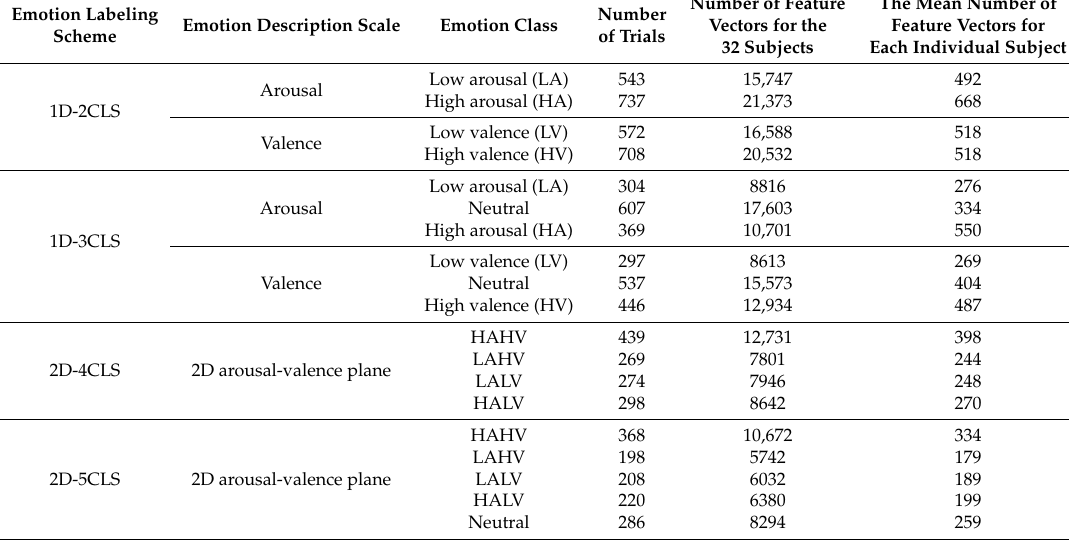
Table 1. The number of trials and feature vectors per emotion class for each labeling scheme. The table includes the total number of trials for the 32 subjects, the total number of feature vectors (number of trials × number of windows per trial) for the 32 subjects and the mean number of feature vectors (number of trials × number of windows per trial/32 subjects) for each individual subject. Emotion Labeling Emotion Description Scale Emotion Class Scheme